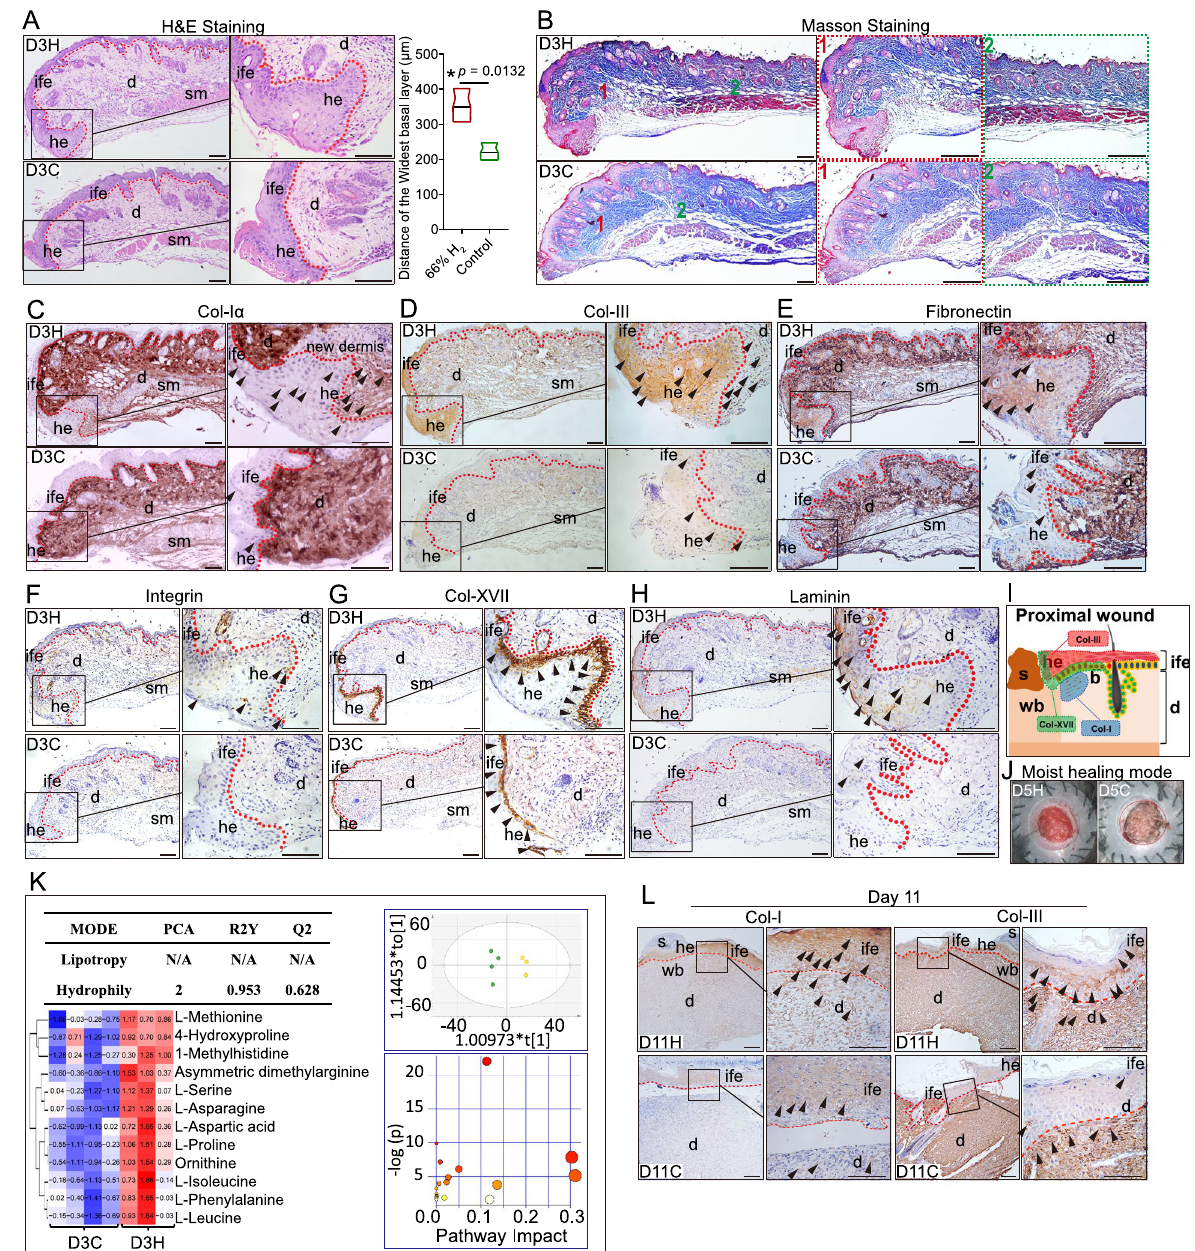
Fig. 2 H 2 treatment promoted different ECM components early deposit in the epidermis, dermis and dermis-epidermis-junction of proximal wound. A Representative H&E staining of the truncated region of epidermis at the wound edge at 3 days post-wounding between two groups; graph indicated the widest basal layer of hypertrophic epidermal wound edge. B Masson staining of different regions of wound edge at 3 days post-wounding between two groups. C – H IHC staining showing the expression of ECM components of Col-I, Col-III, Fibronectin, Integrin, Col-XVII, and Laminin, respectively in the wound edge between D3H and D3C groups. I Scheme of a proximal wound section indicating the histological localization of three kinds of collagens: Col-I (dermis), Col-III (epidermis), and Col-XVII (DEJ) expression after H 2 treatment during the re-epithelialization process. J Representative image of day 5 post-wounding indicating the moist haling mode possibly triggered by the early ECM deposition induced by H 2 treatment. K Overview of mapping of metabolic differences between the 66% H 2 and control groups as well as PCA analysis and pathway enrichment of differential metabolomes; R 2 X fraction of variance for the model; Q 2 predictive ability of the model. L IHC = = staining showing the expression of Col-I and Col-III between D11H and D11C groups. Data in A processed unpaired t test, and were plotted as Mean SEM. * P value < 0.05; ** P value < 0.01; *** P value < 0.001; no stars for P value > 0.05; scale bar 100 μm. Red line indicates the boundary between ± = the epithelium and dermis. Black arrowhead indicates positive-expressing cell. d, dermis; he, hypertrophic epidermal wound edge; ife, interfollicular epithelium; sm, smooth